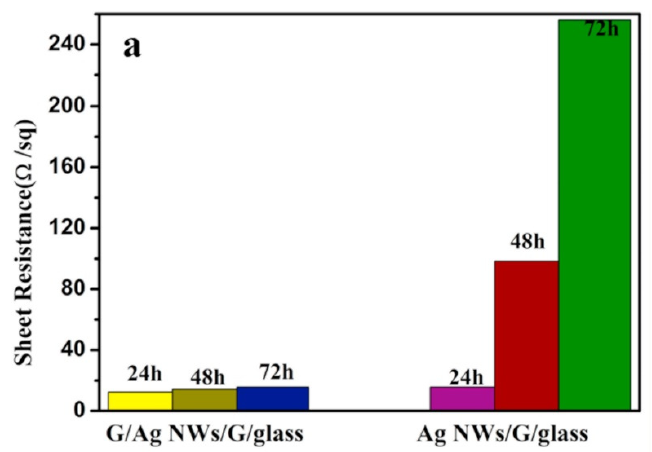
Figure 10. UV–VIS spectra of graphene films grown on glass with varying growth time (5, 15, 25, and 30 min) and the corresponding sheet resistance [50].